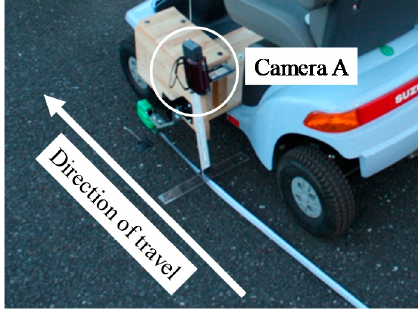
Figure 10. Installation of Camera A.